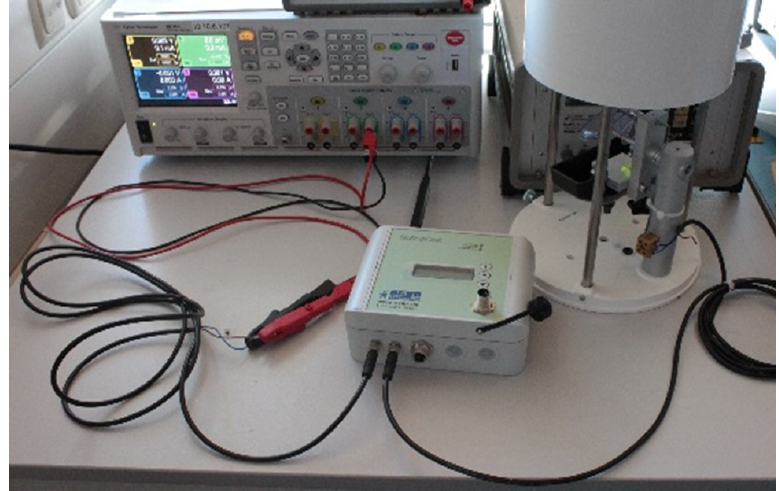
Figure 8. Test setup for the accurate recording of power consumption. A precipitation sensor RG50 tipping bucket was used in the power consumption tests. The RG50 is a highly accurate precipitation gauge with pulse output for data collector systems. It has a plastic rocker with ball bearings on one side and a bubble level and adjustment screw. The precipitation gauge can optionally be equipped with a heater so that exclusively for recording precipitation quantities in the form of pulse